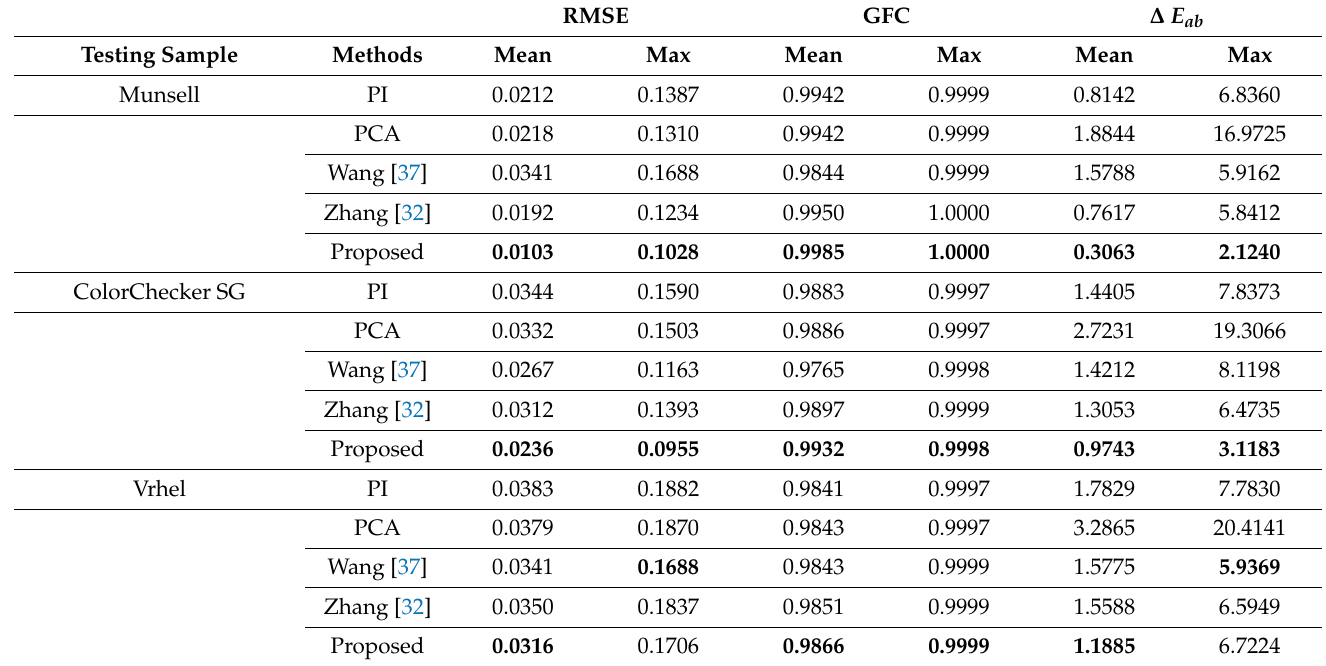
Table 1. Results of recovered spectral reflectance for different testing samples using different spectral recovery